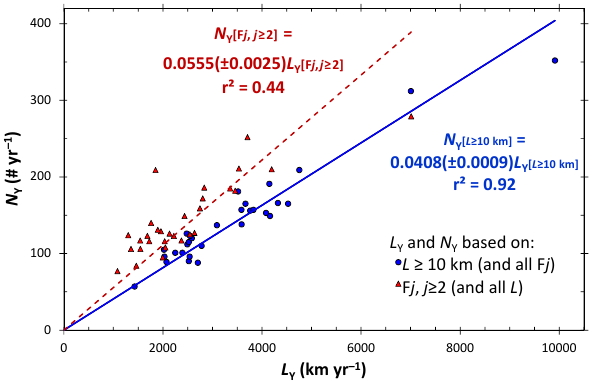
Fig. 9. For continental USA severe tornadoes ( L ≥ 10km), 1982– 2011, the number in a given year, N Y , is given as a function of the total path length in that year, L Y . Results are given for two definitions for severe tornadoes: (i) (blue circles) tornadoes with L ≥ 10km (F0 to F5 considered), (ii) (red diamonds) tornadoes with Fujita (or Enhanced Fujita) scale intensities greater than or equal to F2 (all path lengths L considered). The best-fit linear correlations are shown and given in Eqs. (11) and (12), with uncertainties given as ±1 s.e. (standard error) of the slope. Tornado path length data L are from NOAA